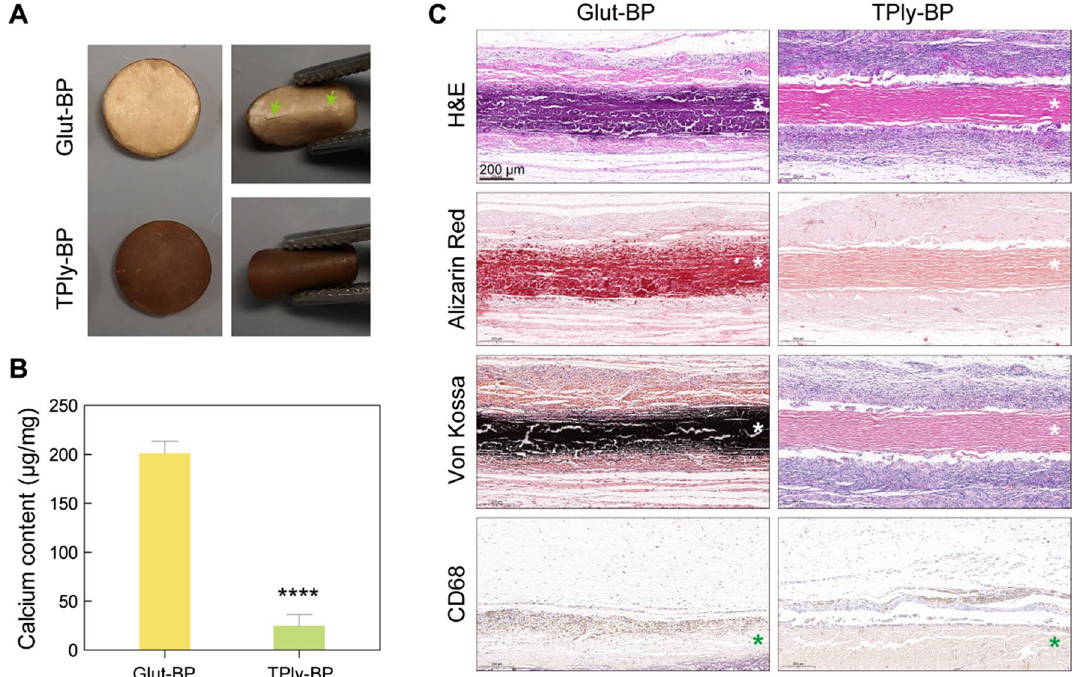
Fig. 7 Calcification of Glut-BP and TPly-BP after subcutaneous implantation in SD rats for 60 days. A Photographs of Glut-BP and TPly-BP removed from the SD rat. The green arrow indicates the crack of GA after half-folding. B Calcium contents of Glut-BP and TPly-BP removed from the SD rat determined by ICP ‒ OES (n 3). C Histological analysis of Glut-BP and TPly-BP removed from the SD rat. Calcium deposits were identified by Alizarin = red and Von Kossa staining; H&E staining was used for histomorphological evaluation; immunohistochemical staining of CD68 was used to label macrophages (CD68-positive cells are marked brown). Scale bar, 200